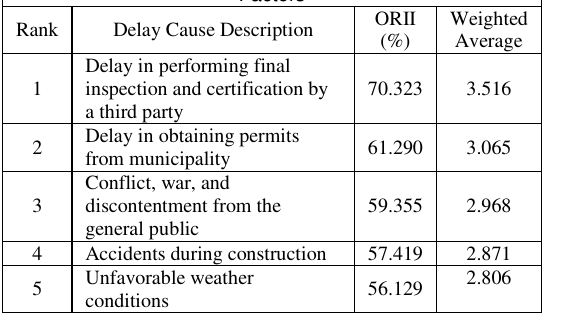
Table 7: Ranking of Delay Causes Related to External Factors